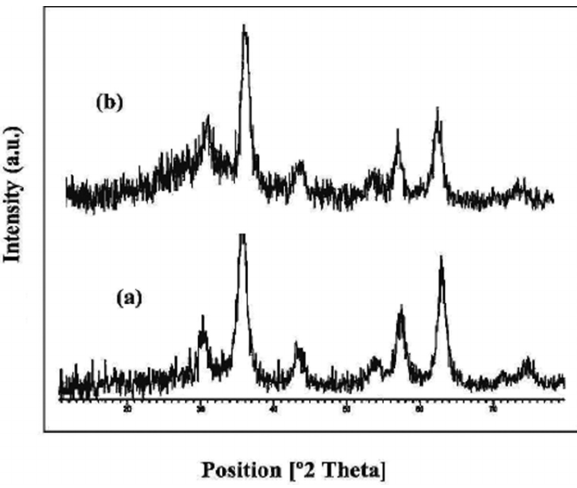
Figure 1: The XRD pattern of (a) Fe nanoparticles.